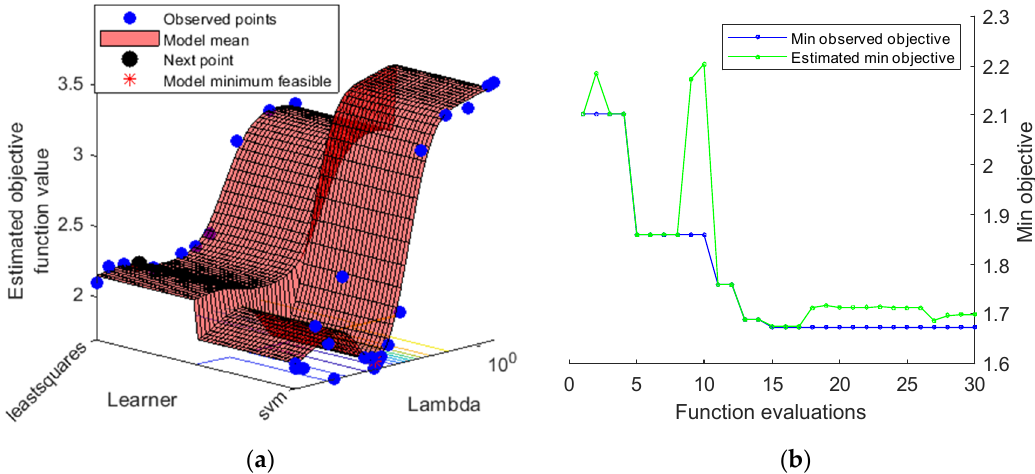
Figure 8. Validation of internal pillar moisture content: ( a )—objective function model, ( b )—Min objective vs. Number of function evaluations.